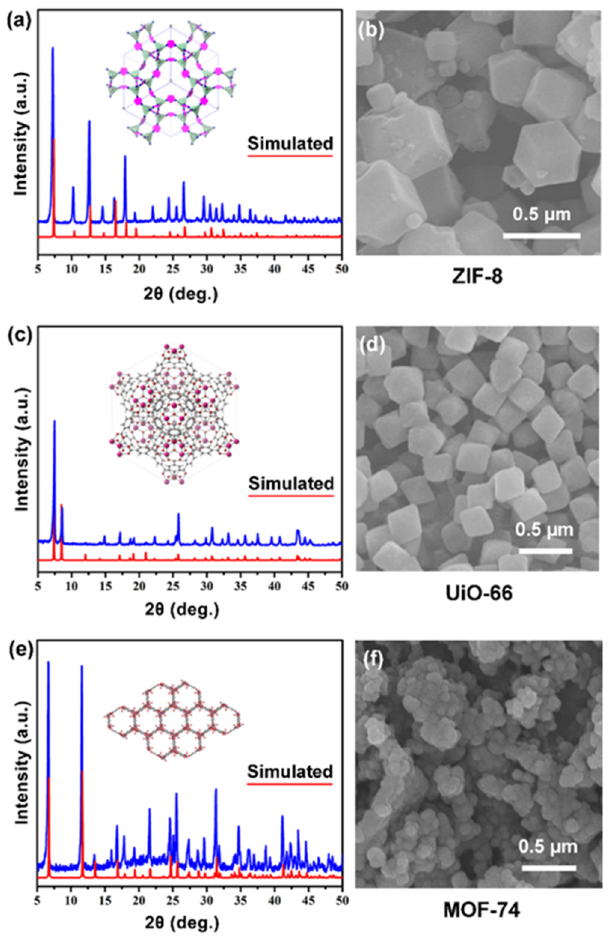
Figure 1. XRD experimental and simulated patterns: ( a ) ZIF-8; ( c ) UiO-66; ( e ) MOF-74. SEM images: ( b ) ZIF-8; ( d ) UiO-66; ( f ) MOF-74.